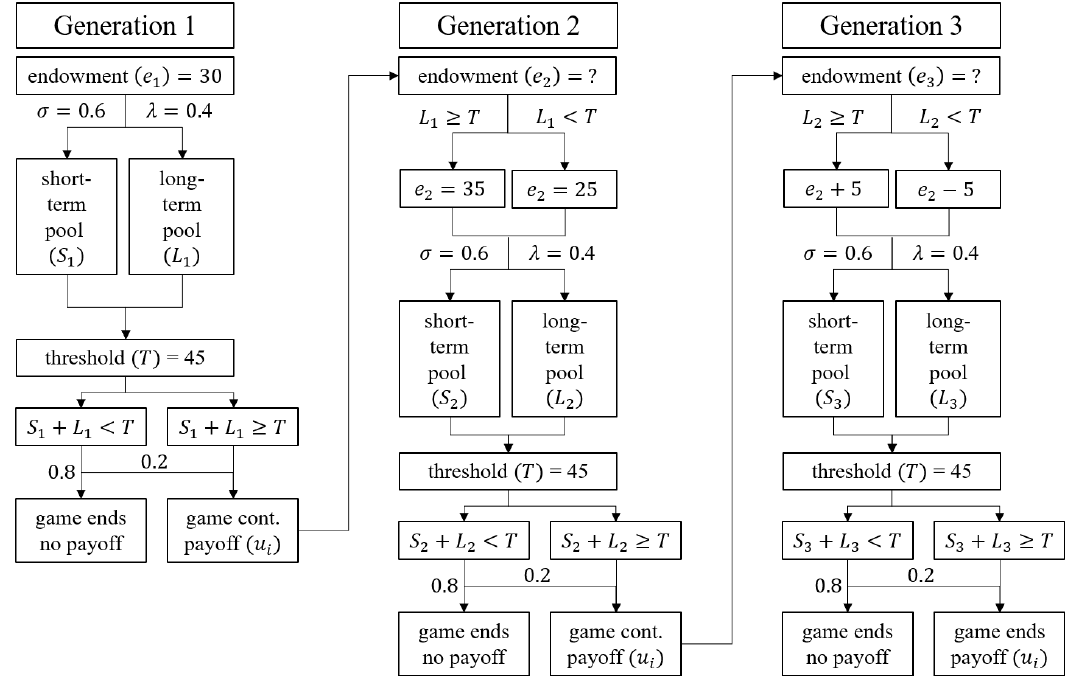
Figure 1. Structure and parameters of the multi-level conflict game in climate change mitigation.